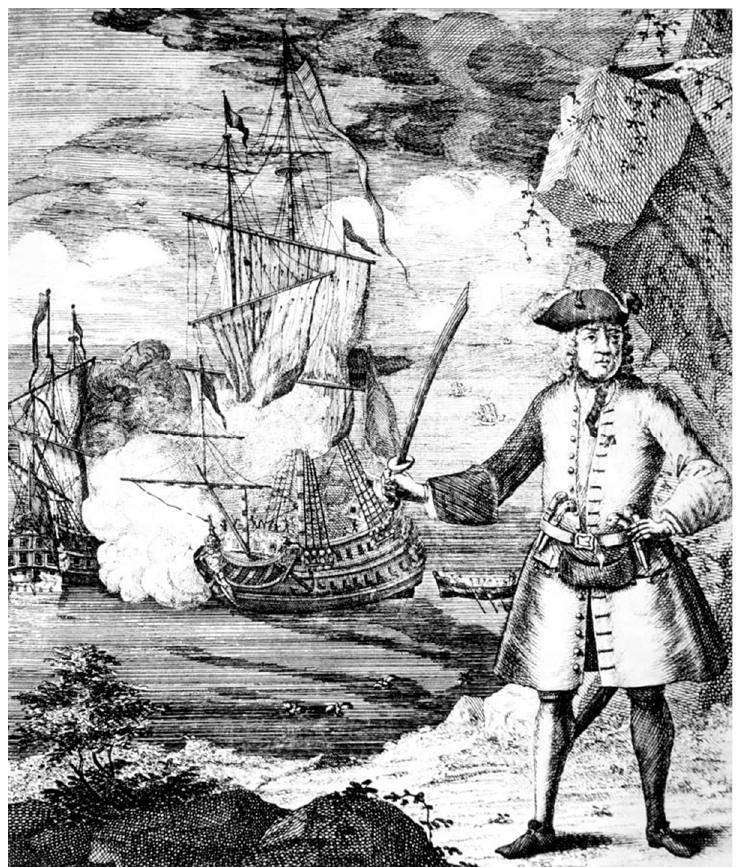
Figure A1. An eighteenth-century engraving of Captain Avery. This image is taken from WikiMedia Commons (a database of public domain material). PortCities.org.uk identifies the artist as W. Tett and the engraver as W. Pritchard with date unknown. The original is credited to The National Maritime Museum, Greenwich, UK.